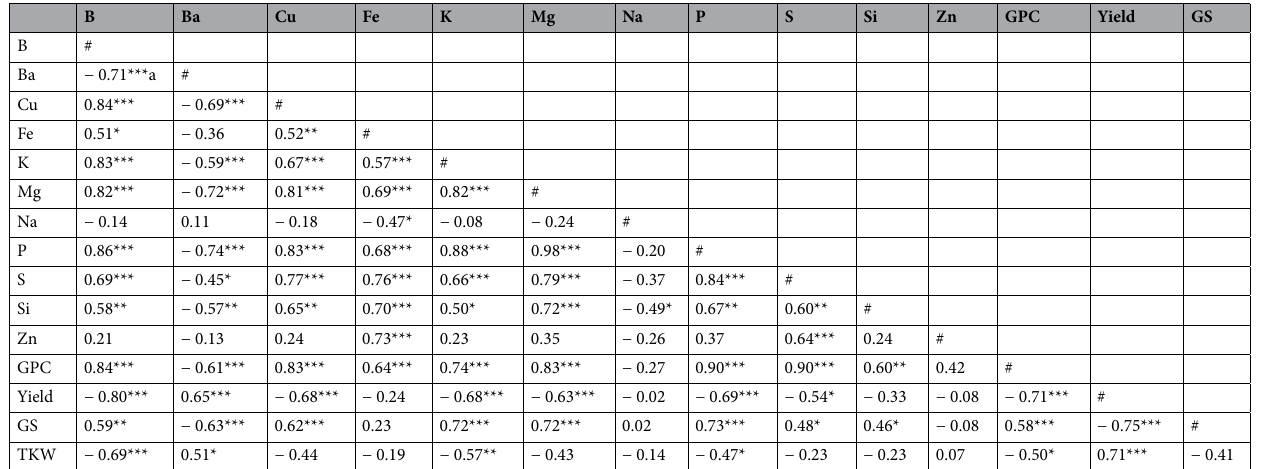
Table 3. Pearson correlation conflict of mean GMC a , GPC (%), Yield (gr), GS, TKW (gm) measured in a block design experiment 2016–17. a GMC: Grain mineral concentration of elements (ppm): Barium (Ba), Boron (B), Copper (Cu), Iron (Fe), Magnesium (Mg), Phosphorus (P), Potassium (K), Silicon (Si), Sodium (Na), Sulphur (S), Zinc (Zn), Grain protein concentration (GPC), Yield (g), and Grain size (GS). b Confidence interval is marked * < 0.05 ** < 0.01 *** <